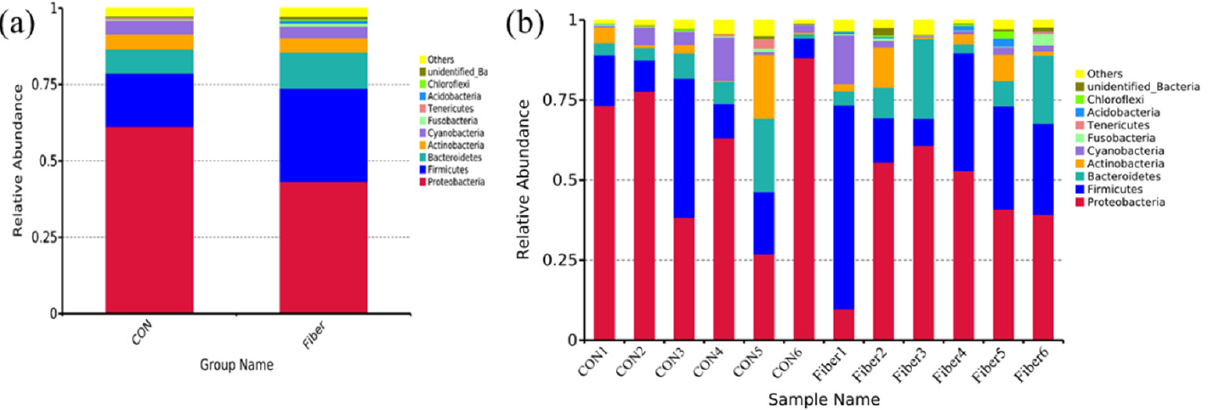
Figure 6. Top 10 bacterial phyla of microbial community in colonic digesta of newborn piglets between two groups ( a ) and each sample ( b ). Table 4. The relative abundance of main bacterial phyla in the colon of newborn piglets.